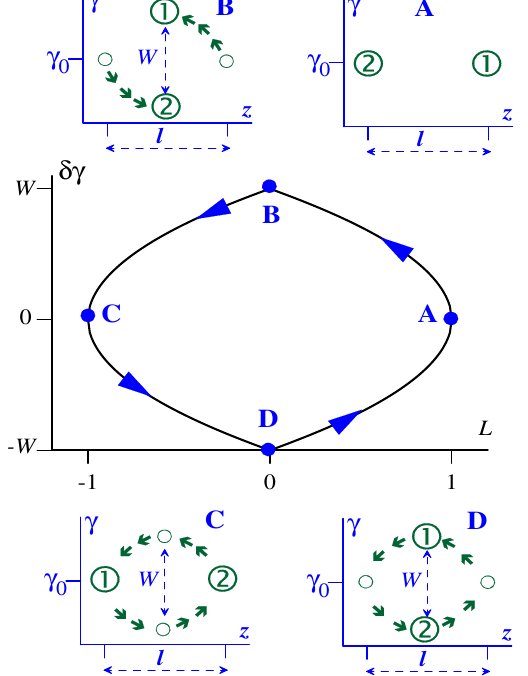
FIG. 4. The model of an electron bunch consisting of two particles. Phase plane describing the evolution of the bunch in the negative-mass undulator, as well as axial positions and energies of the two electrons at different moments of the time, including the initial state (A) and the point of the maximal axial com- pression (B).